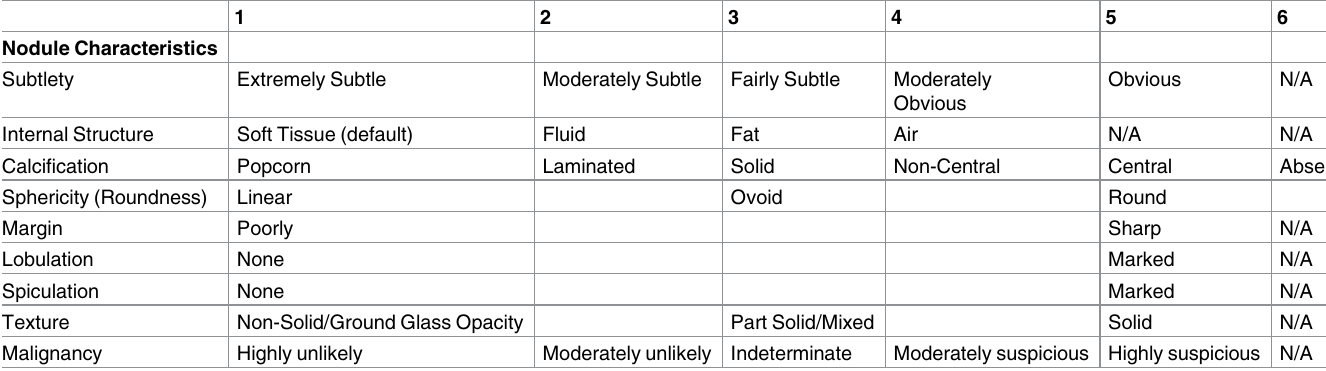
Table 1. Annotation of nodule characteristic